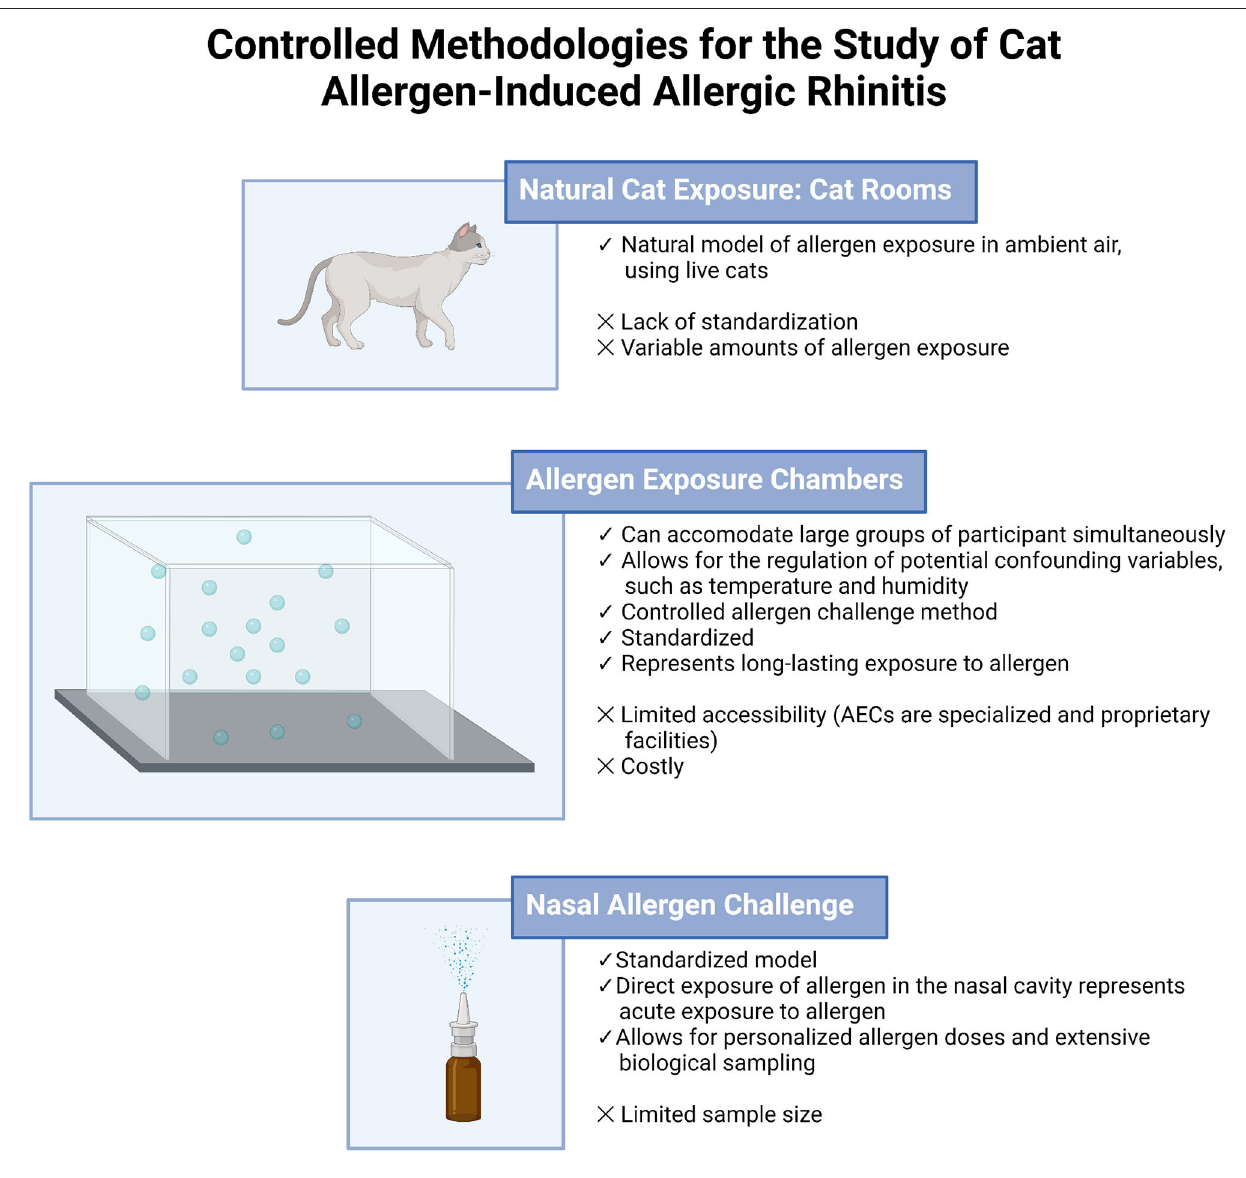
FIGURE 1 | Comparison of models used in the investigation of cat allergy.